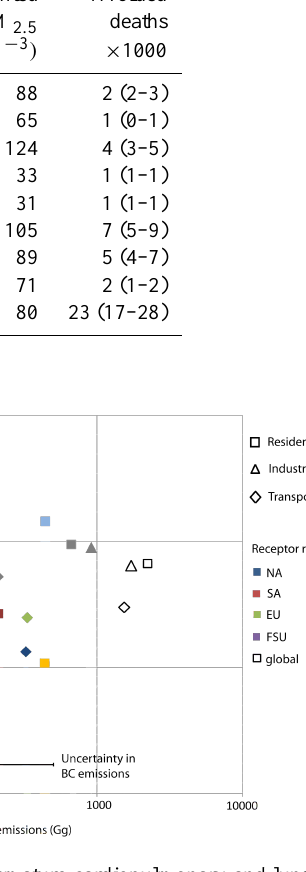
Fig. 8. Annual avoided premature cardiopulmonary and lung can- cer deaths per unit BC emissions reduced vs. total BC emissions (Gg) for particular source sectors within each region. Avoided deaths are estimated in the three simulations where global emis- sions in each sector are halved, and shown for each receptor region; these deaths are compared with emissions from each region, as- suming that deaths from inter-regional transport are negligible (Ta- ble 2). Uncertainty in the mortality estimates is a factor of 0.23 from the central estimate, which includes uncertainties in the cardiopul- monary and lung cancer CRFs only. Uncertainty in BC emissions is assumed to be a factor of 2 from the central estimate (Bond et al., 2004, 2007). Since these uncertainties are factor differences from the central estimate, they are identical for each data